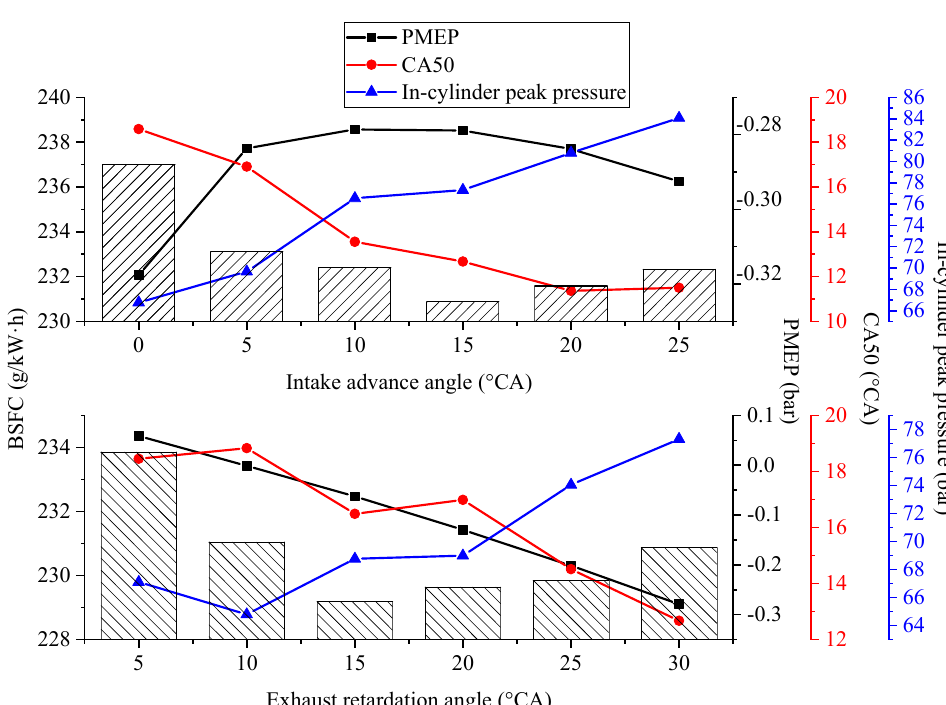
Figure 13. BSFC and related effects versus intake advance angle under baseline EVC, and BSFC and related effects versus exhaust retardation angle under the Miller cycle (point of operation: n = 3000 rpm, BMEP = 15 bar, exhaust retardation angle = 25 °CA, CA50 = 8 °CA).